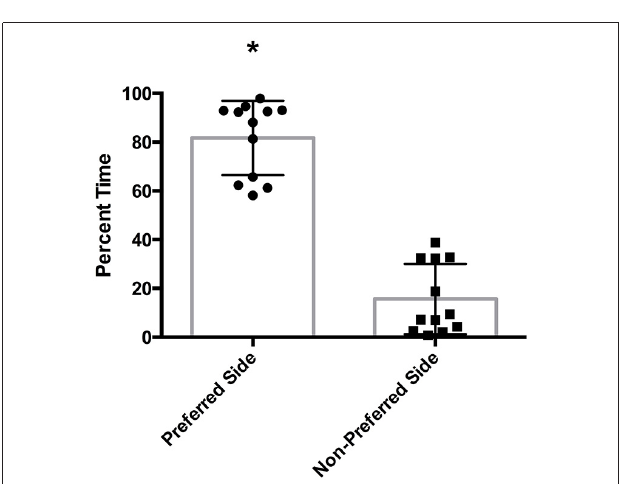
FIGURE 3 | Preferred room during final preference test. Subjects displayed a significant preference for one room during the final preference test (* p < 0.001). Individual data points are plotted with the Mean ± SEM.